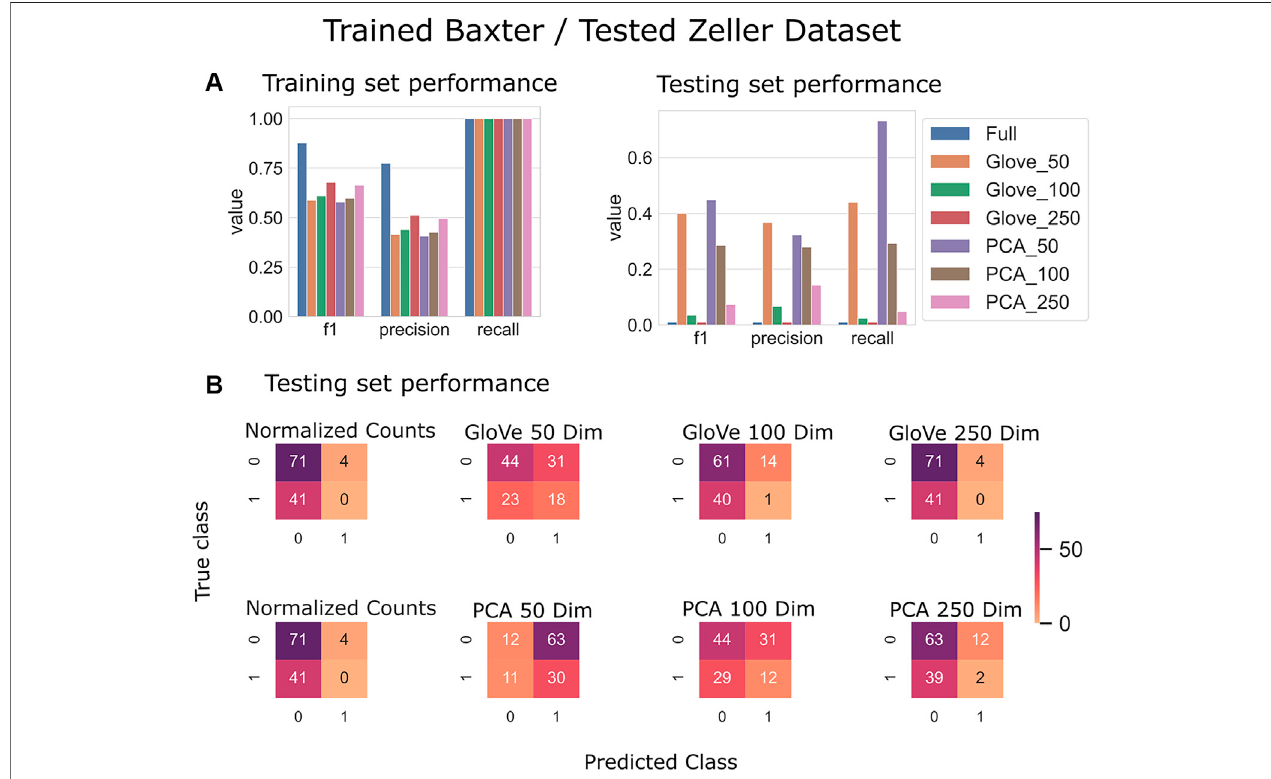
FIGURE 5 | Predicting Colorectal Cancer: Models trained on the Baxter dataset and tested on the Zeller dataset. (A) : Models built using GloVe embedded data, PCAembeddeddata(50,100,or250dimensions),ornormalizedASVcountsperformanceontrainingandtestingsets. (B) :Confusionmatricesshowingthedistribution of correct to predicted classes on the testing